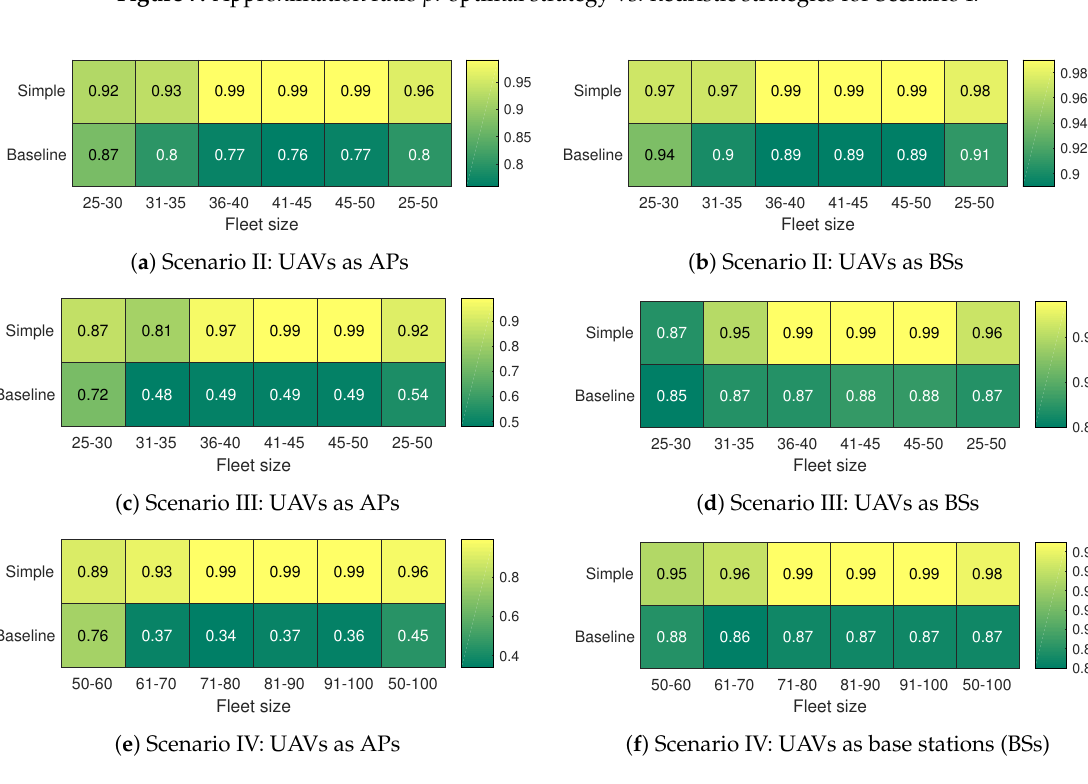
Figure 8. Approximation ratio ρ : betweenness centrality heuristic algorithm (BETA) vs. other suboptimal